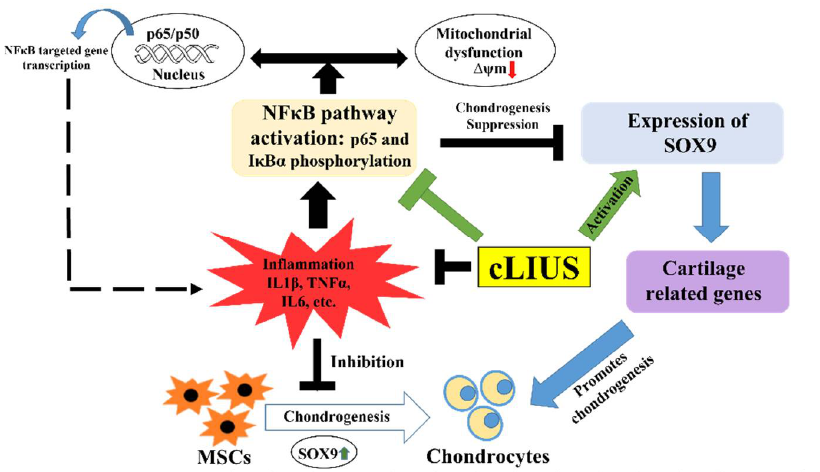
Figure 8. Schematic representation of the cLIUS-induced chondroprotective mechanisms. cLIUS promoted MSC chondrogenesis by inhibiting the cytokine-induced activation of the NFκB signaling pathway by engaging the tIκBα feedback mechanism while upregulating the expression of SOX9, the collagen II transcription factor. It is also posited that cLIUS acts to preserve the mitochondrial potential, which is impacted by cytokines. Supplementary Materials: The following are available online at www.mdpi.com/xxx/s1, Figure S1: Cell viability of hydrogel scaffolds. Figure S2: Localization of pNFκB and COLII in cLIUS treated and non-treated control hydrogel scaffolds. Figure S3: Gene expression analysis in MSCs exposed TNFα (A) and IL6 (B). Figure S4: Localization of pNFκB in MSCs exposed to cytokines IL1β (A), TNFα (B) and IL6 (C). Figure S5: Phosphorylation of NFκB and IκBα in cLIUS treated and non- treated control samples.